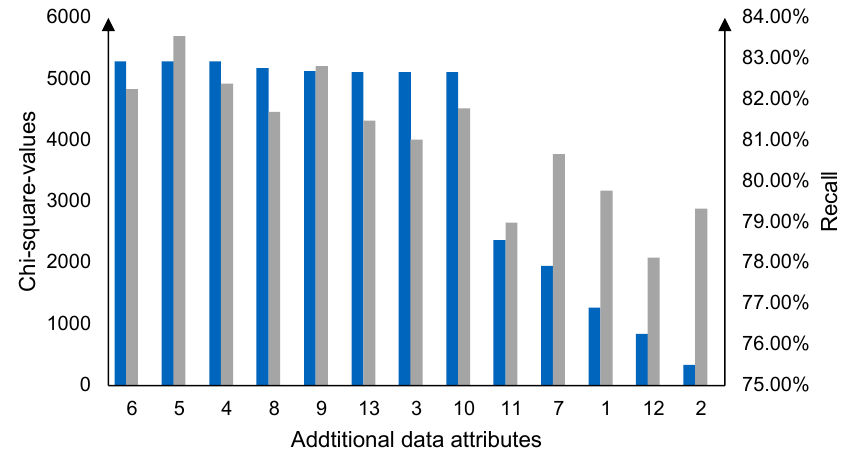
Figure 6. Results of chi-square test and resulting model quality with single additional